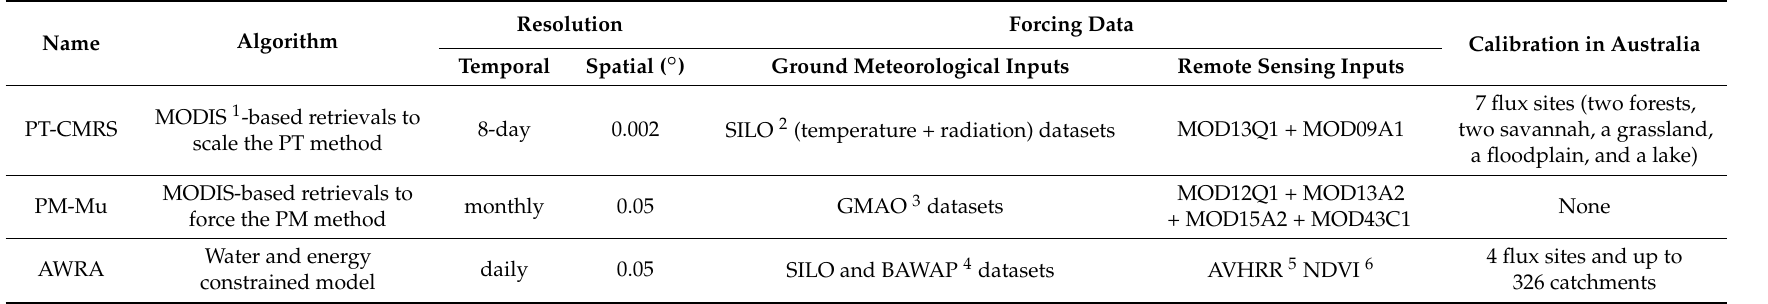
Table 1. Summary of the ET datasets used in this study except for